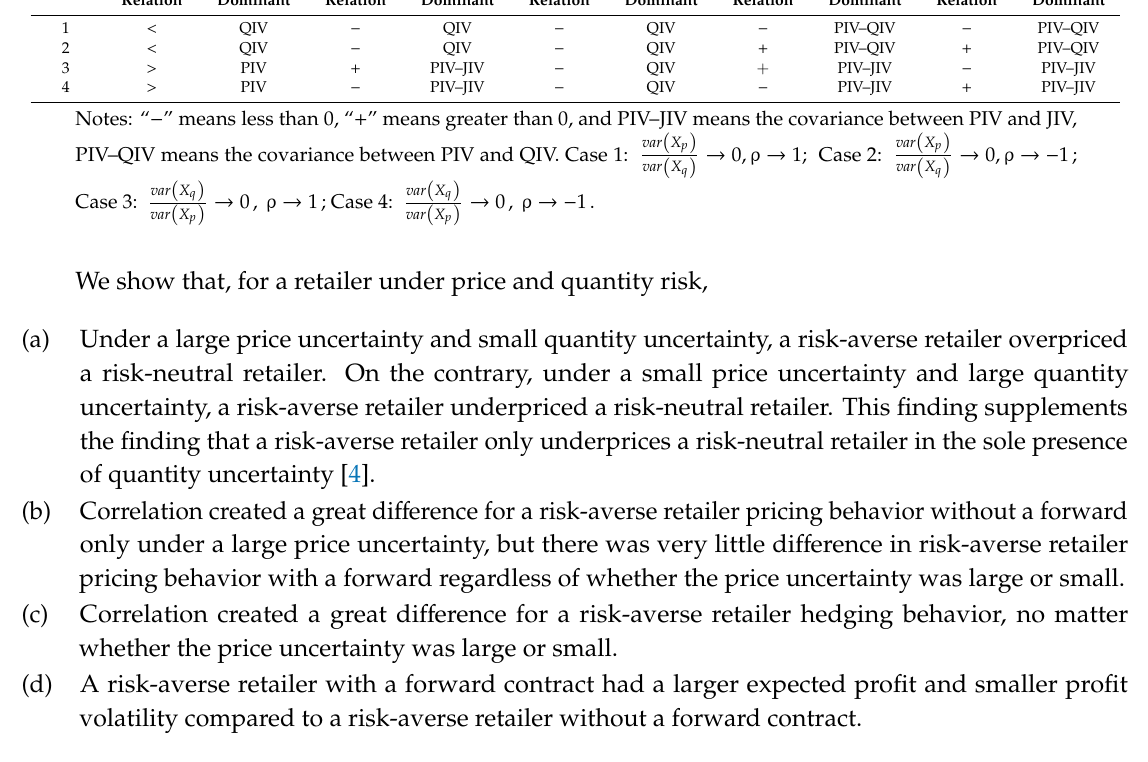
The retail price of models 1 and 3 are identical by definition, so we only plotted the retail price of model